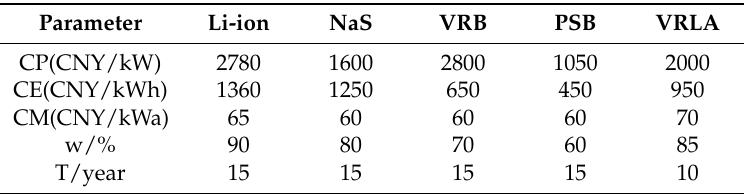
Table 1. The parameters of different